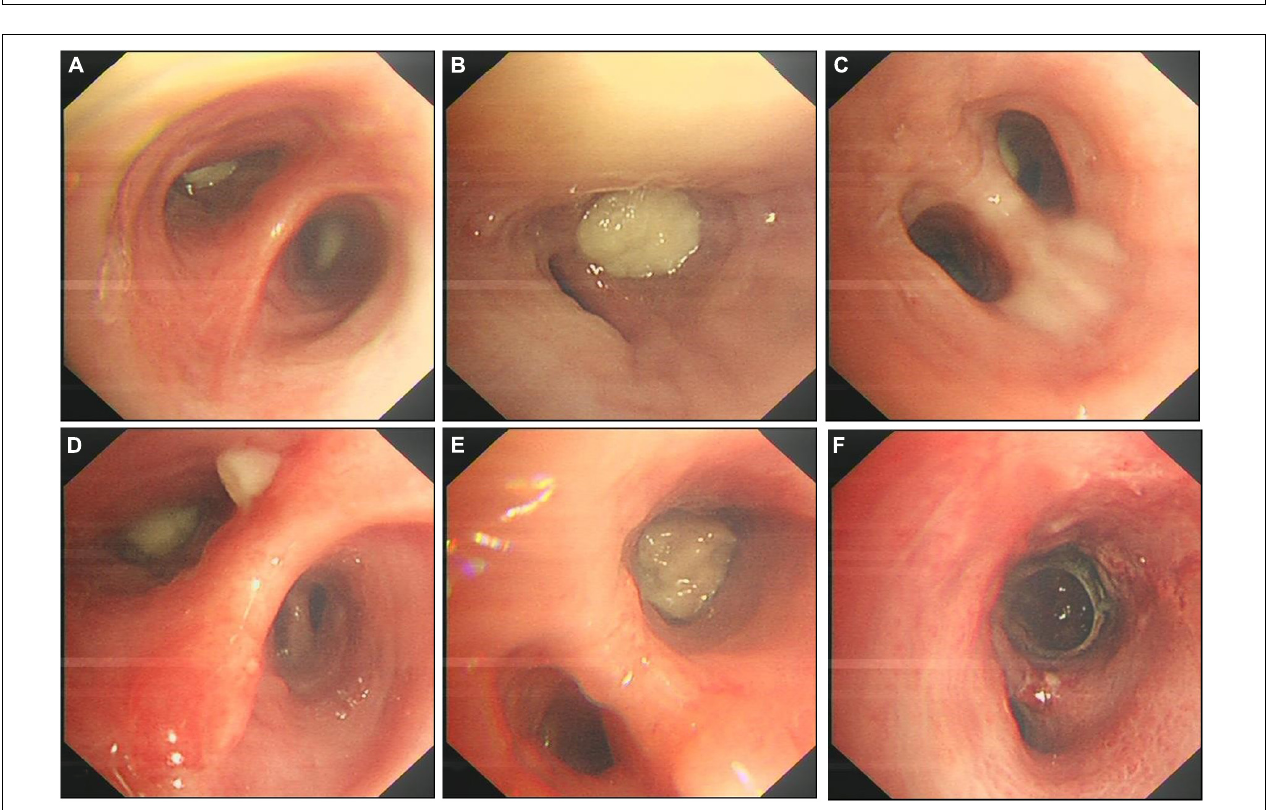
FIGURE 1 | Chest computed tomography images at admission. A consolidation shadow in the right upper and middle lobes, with necrosis containing foci of air. (A,C) lung window; (B,D) mediastinal window.